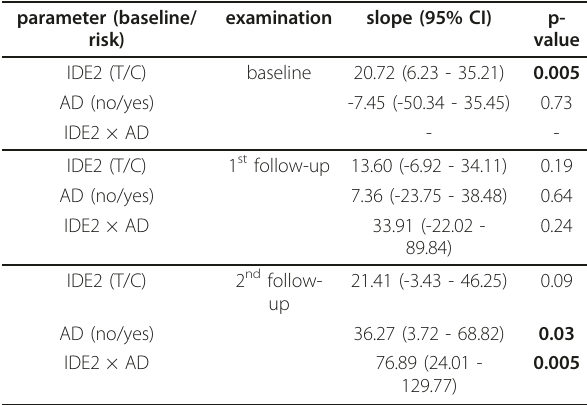
Effect sizes and nominal p-values were derived from multivariate regression analysis with sex and presence of apolipoprotein E (APOE ε 4) alleles as covariates. All IDE2 (SNP rs4646953) genotype groups display a highly significant increase in A b 42 plasma concentration between each of the three